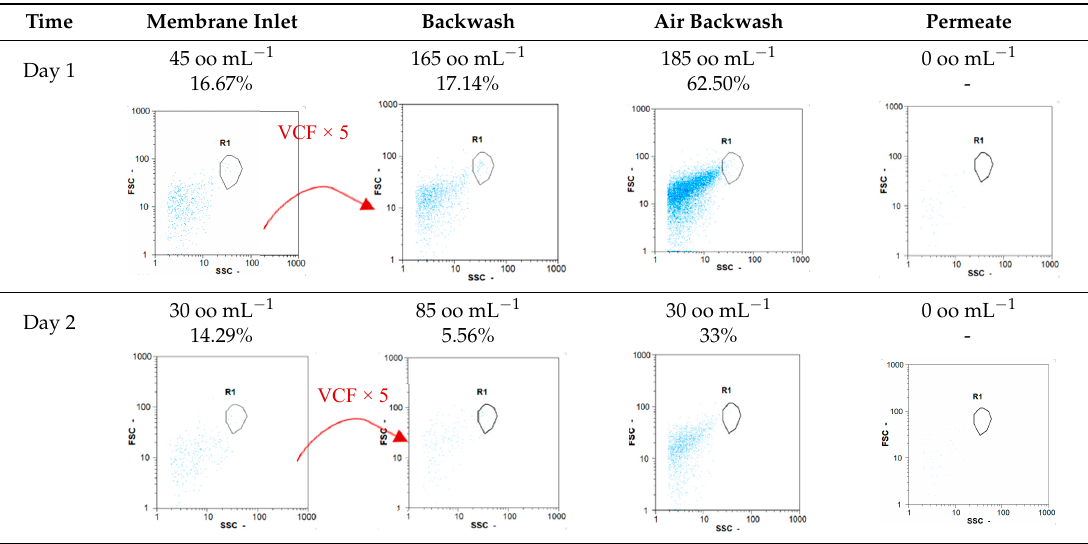
Table 5. Flow cytometry of oocytes—(J = 60 L h − 1 m − 2 and t filtration = 30 min for chronic pollution).